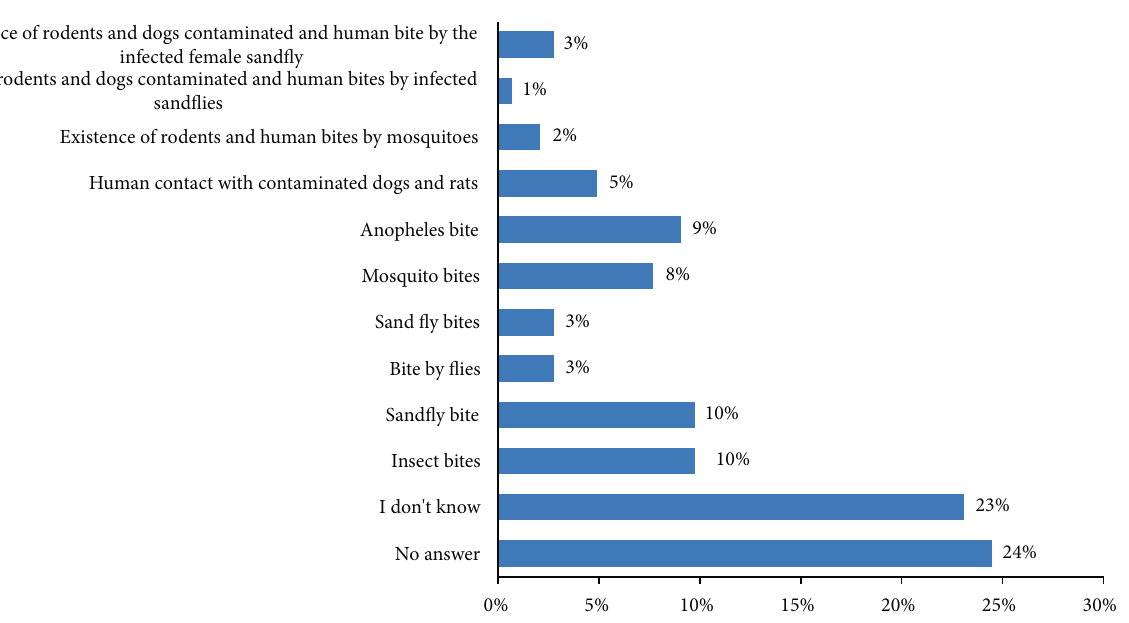
Figure 1: Modes of transmission of leishmaniases according to health